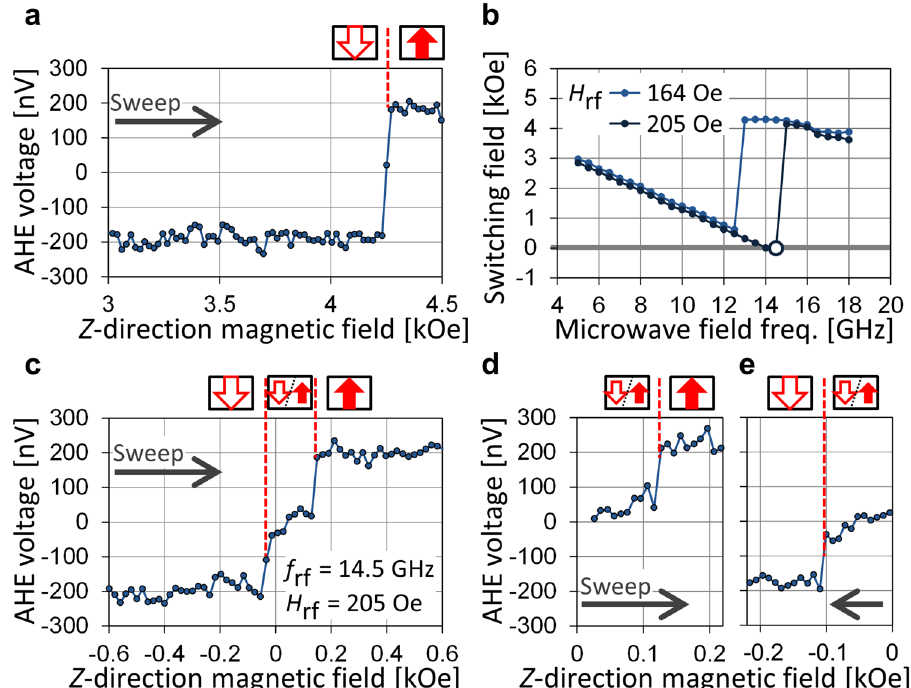
+ 4.3 kOe correspond to Figure 6. ( a ) AHE voltage versus H for the 60-nm sample. Abrupt changes at = H z z switching of the nanomagnet. ( b ) H versus f in the circularly polarized microwave field from CPWs 1 and 2. sw rf The open circle indicates that the reversed domain is formed. ( c ) AHE voltage versus H in the CP microwave z field from CPWs 1 and 2 for = . f 14 5 GHz and = H 205 Oe. ( d ) and ( e ) AHE voltage versus H obtained by rf z rf sweeping H in the upward and downward direction after the reversed domain is formed. The reversed domain z is formed by applying the microwave field with the same parameters as in ( c ), and during the H sweep, the z microwave field is terminated.